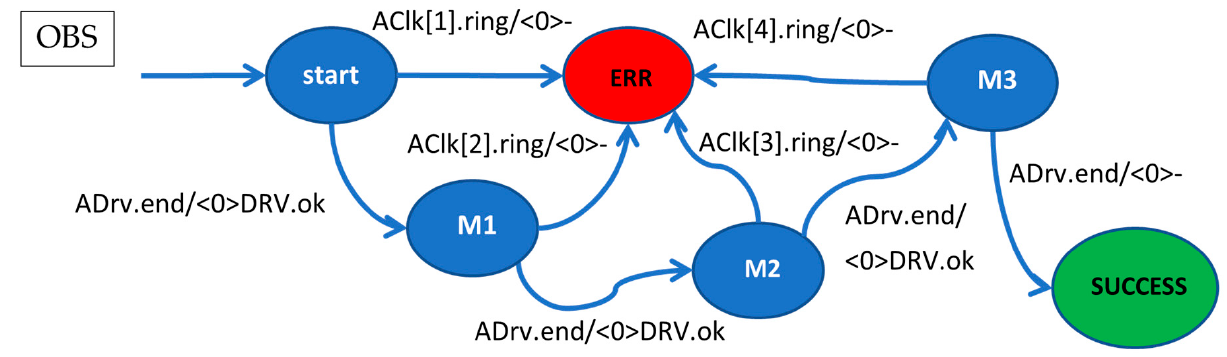
Figure 14. The modi fi ed observer automaton OBS.